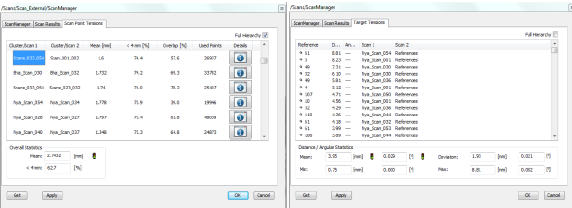
Figure 2. Nyatapola and Bhairavnath temples scan Point Cloud.